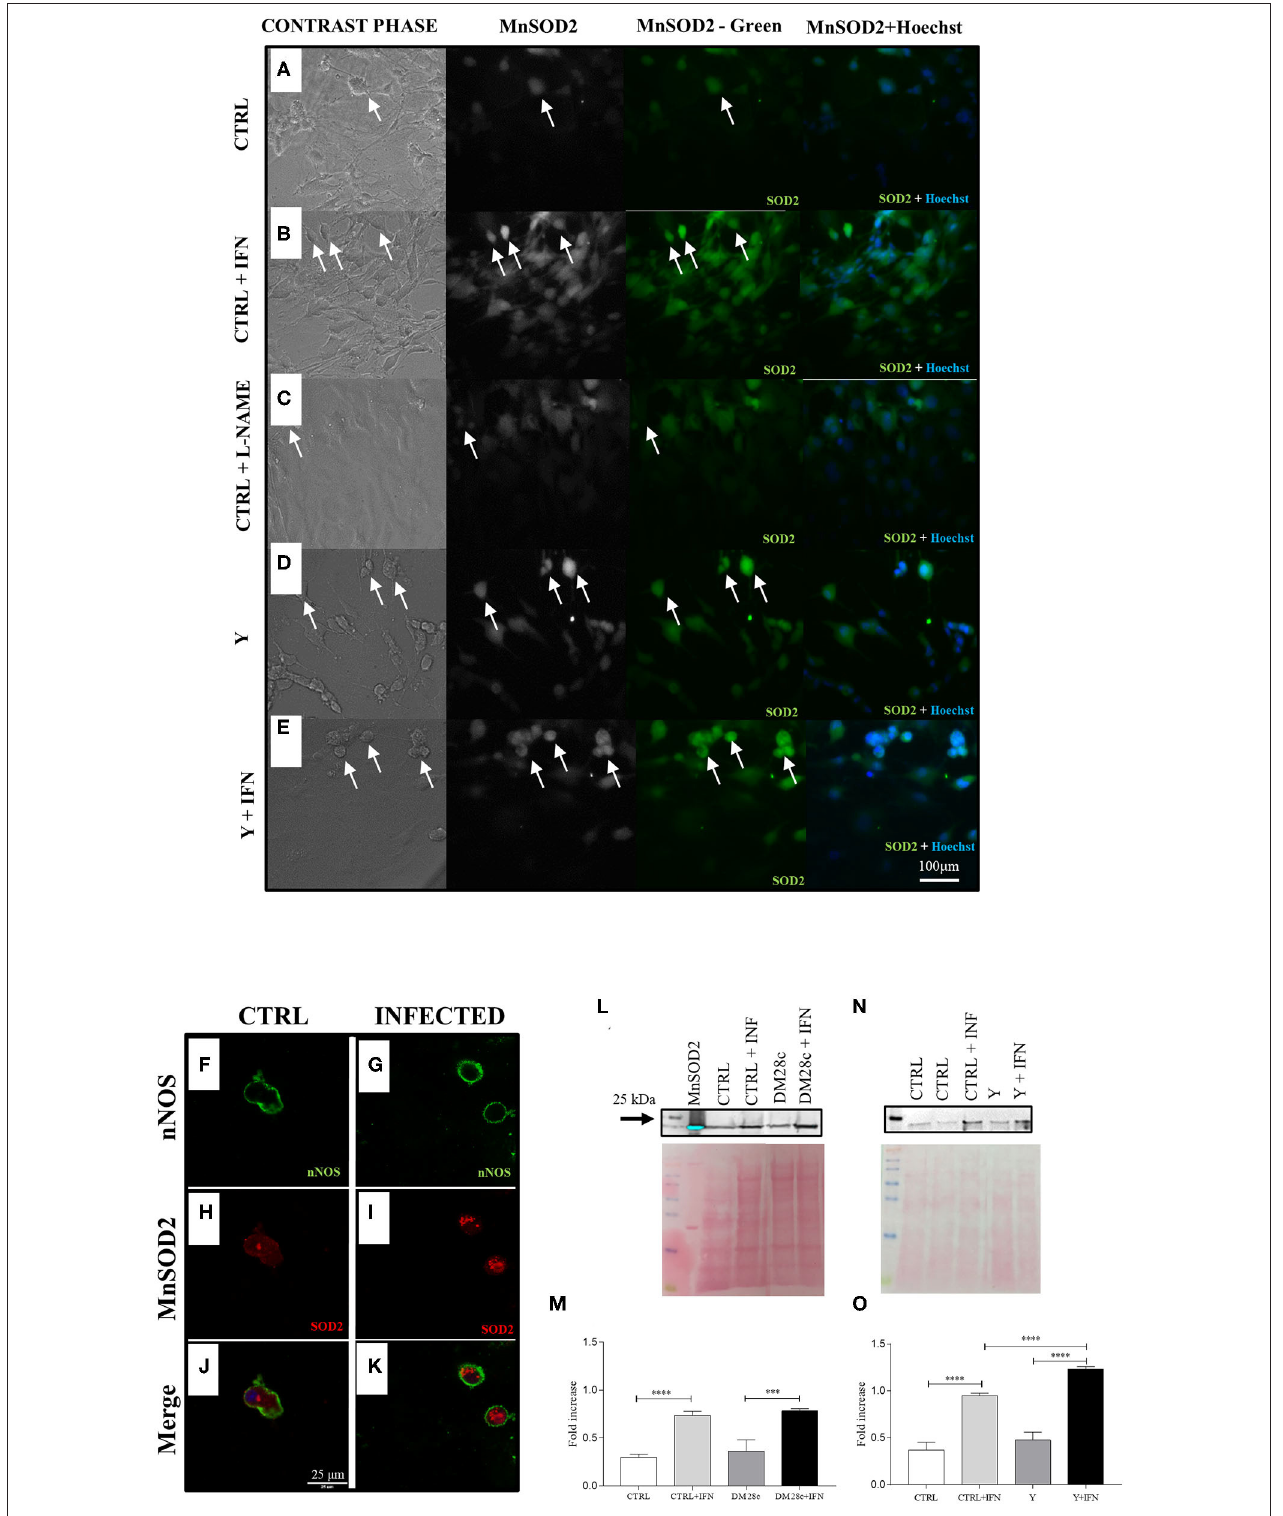
FIGURE 8 | nNOS neurons infected with strains Y and Dm28c show greater expression of MnSOD2. Neurons removed from the myenteric plexus were dissociated, plated, and infected or not with T. cruzi strains Y and Dm28c trypomastigotes, followed up for 72h and had their expression levels of mitochondrial